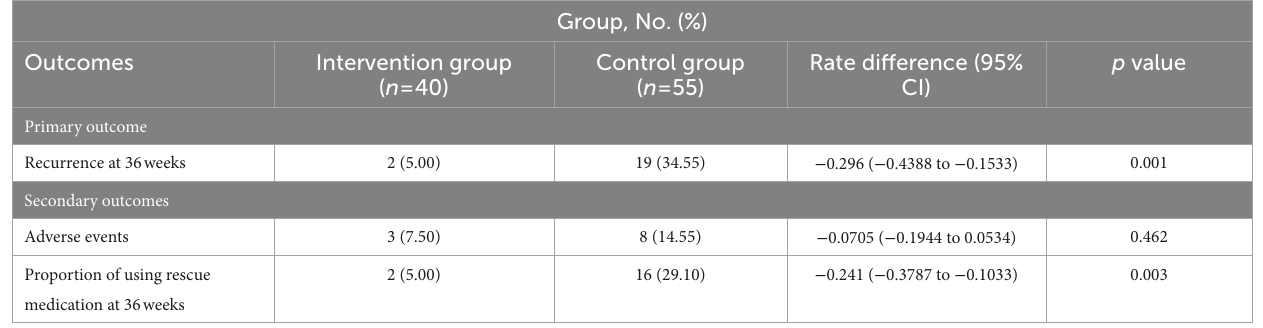
TABLE 2 Recurrence rate and proportion of rescue medication used at week